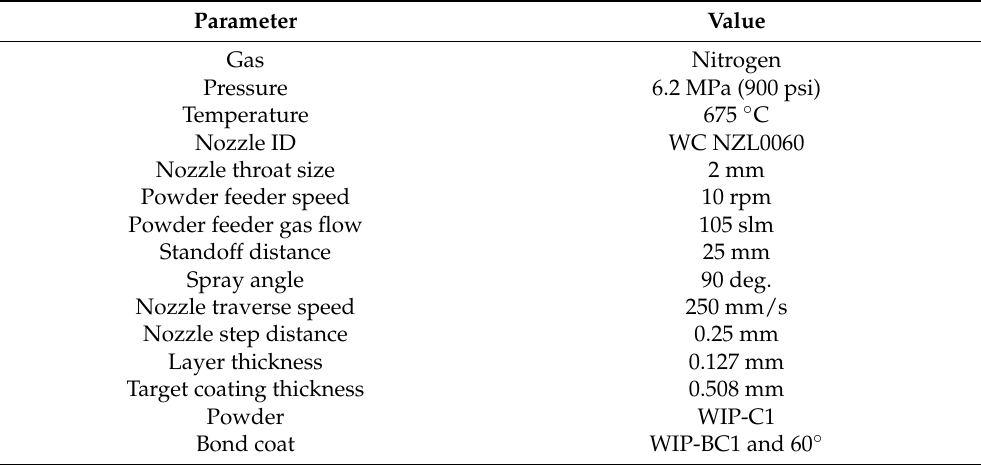
Table 1. Cold spray (CS) deposition parameters used to prepare the fatigue